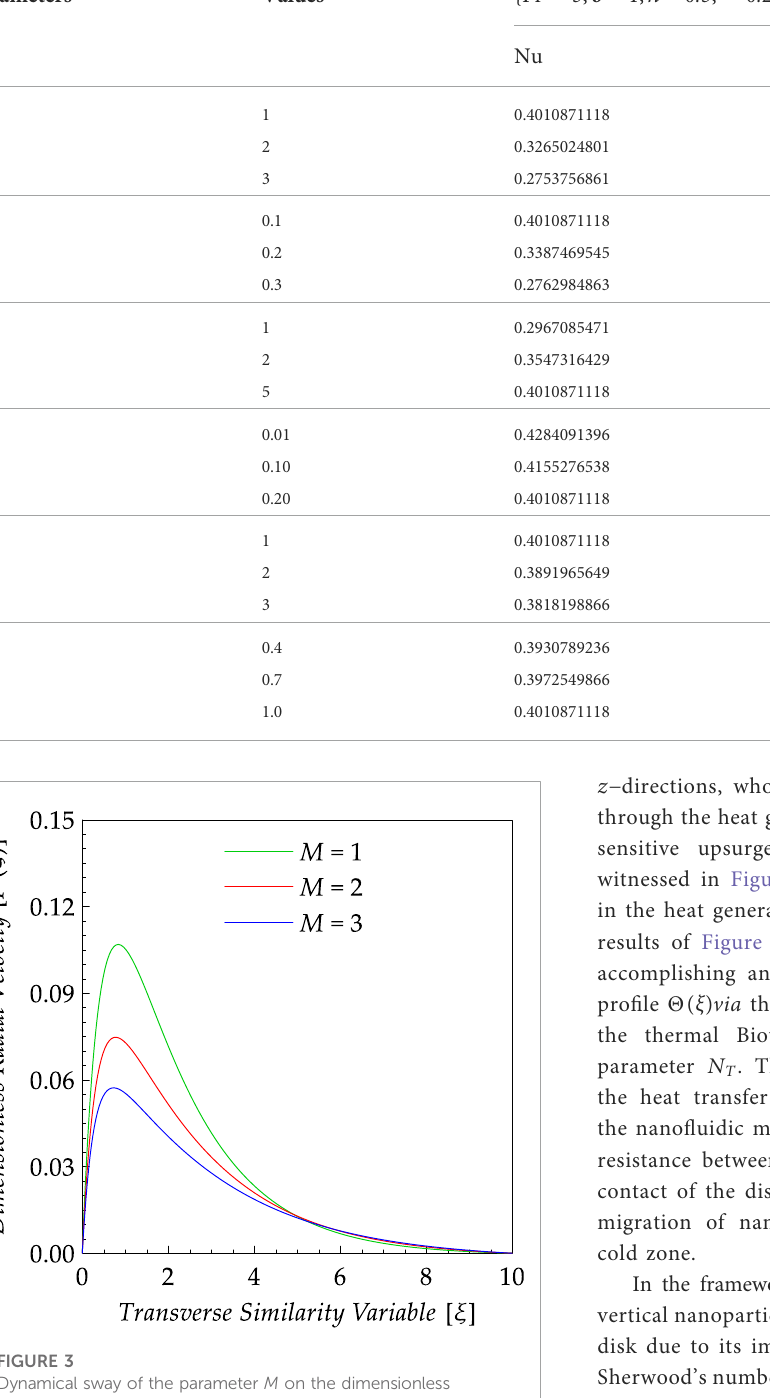
TABLE 5 Numerical estimation of thermal wall characteristics.